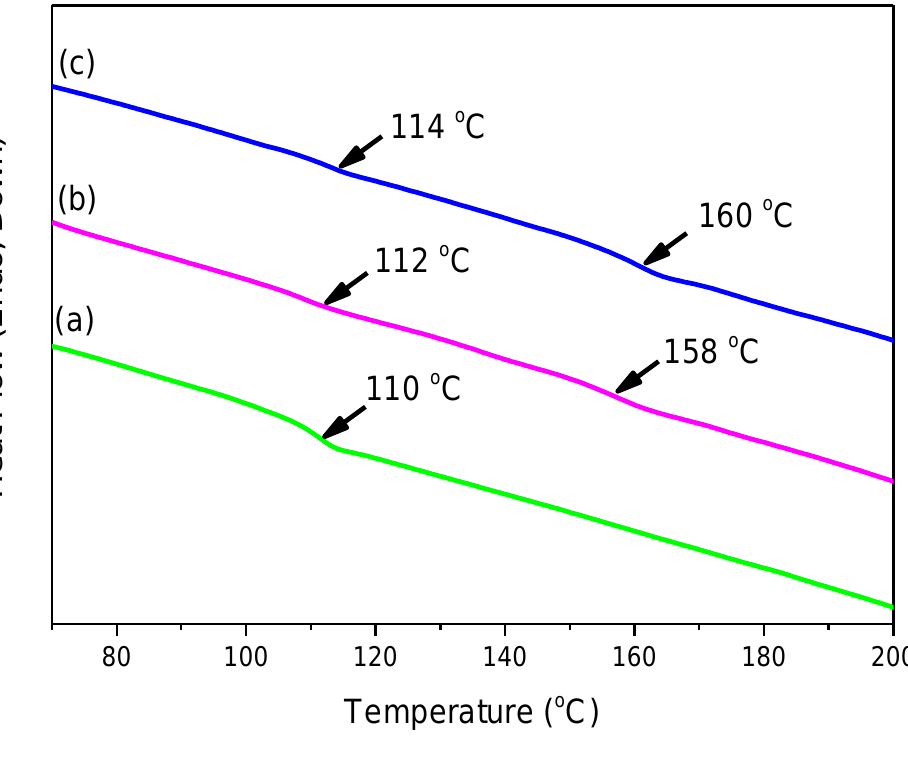
Figure 9. DSC thermograms of ( a ) PS-DDSQ-PS, ( b ) P4VP 62 - b -PS 91 -DDSQ-PS 91 - b -P4VP 62 , and ( c ) P4VP 98 - b -PS 91 -DDSQ-PS 91 - b -P4VP 98 .